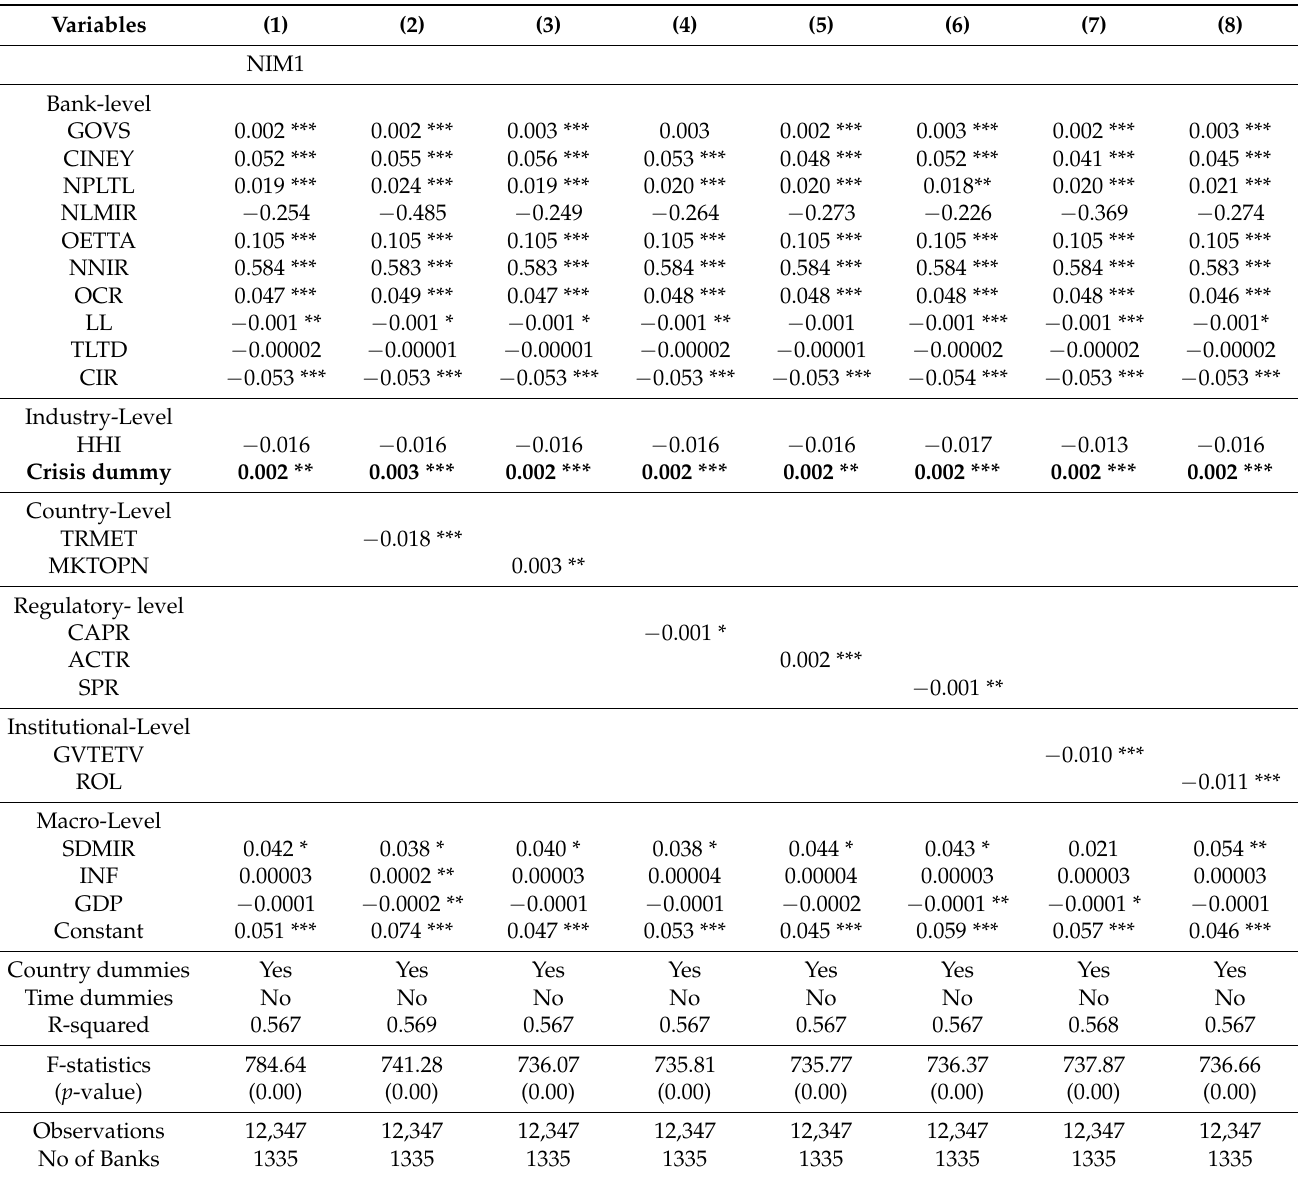
Table 6. Impact of the global financial